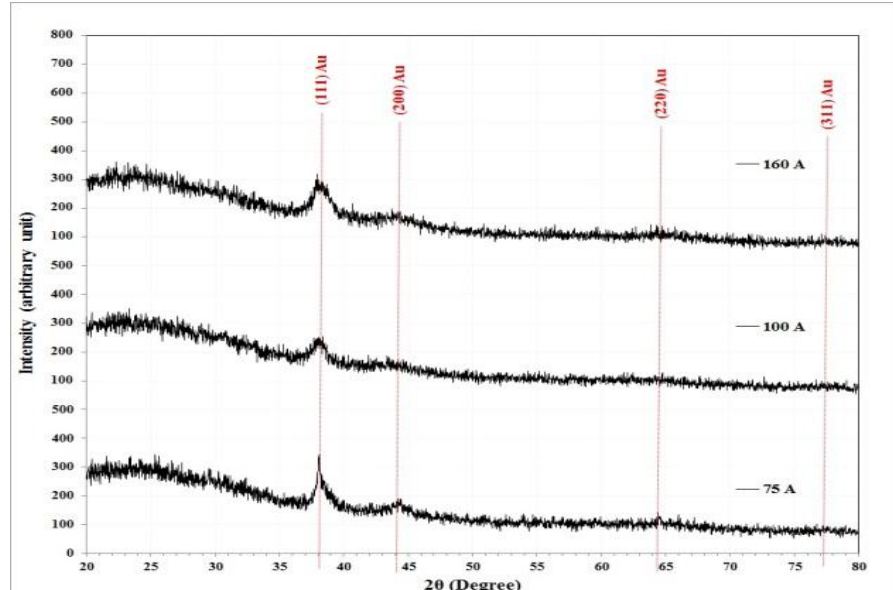
Fig. 4: X-ray diffraction pattern of C-alloy nanoparticles prepared by exploding of wire for a different current (75A, 100A,